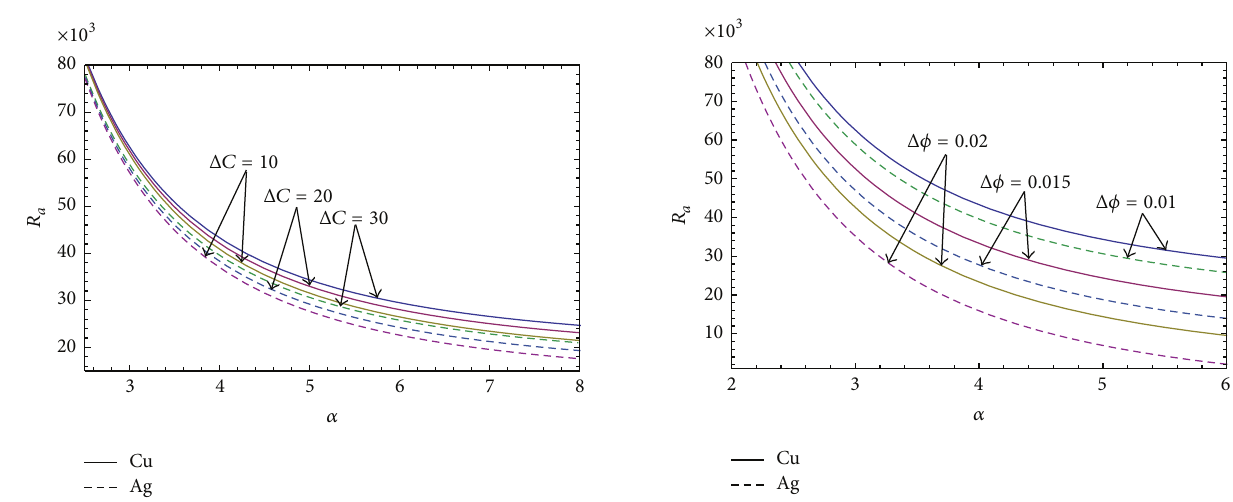
Figure 5: Effect of Δ𝐶 on metallic nanoparticles.